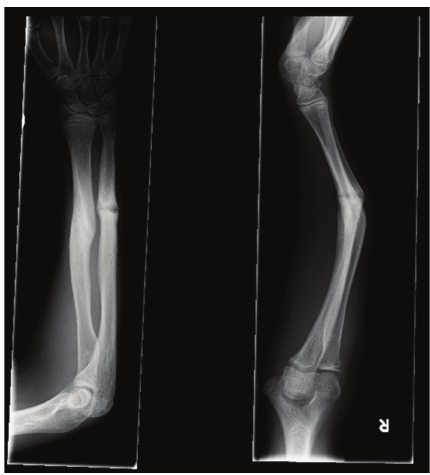
Figure 1: The original deformity—orthogonal views right forearm.